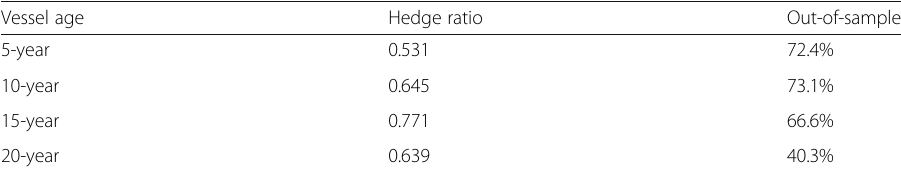
Table 5 Out-of-sample hedge performance Vessel age